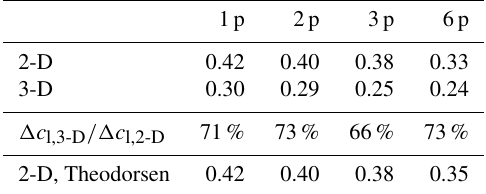
Table 4. c l amplitude, 75% blade cut, 2-D and 3-D